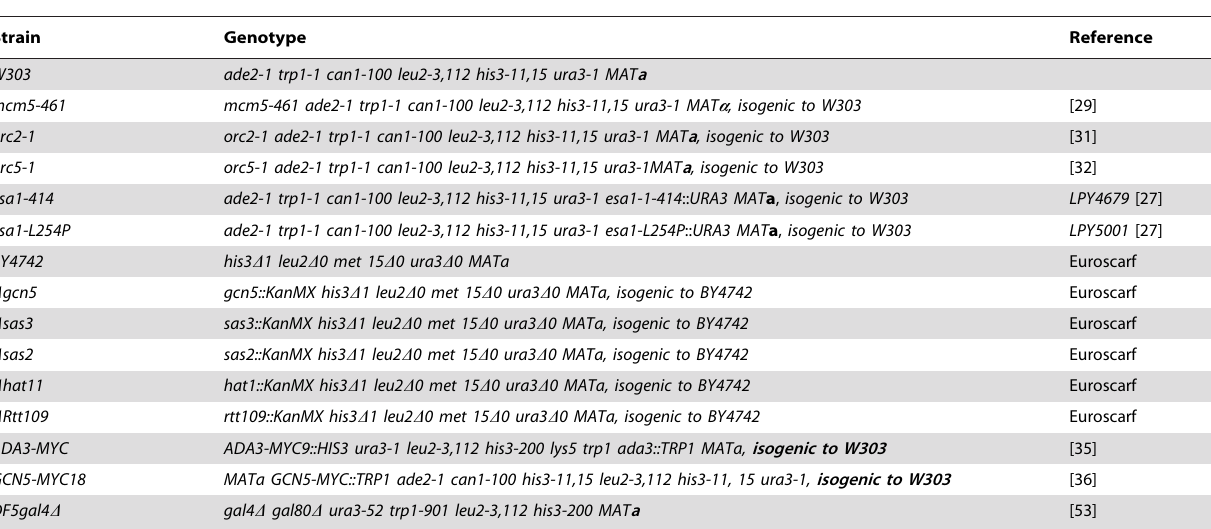
Table 1. Yeast strains used in this study.